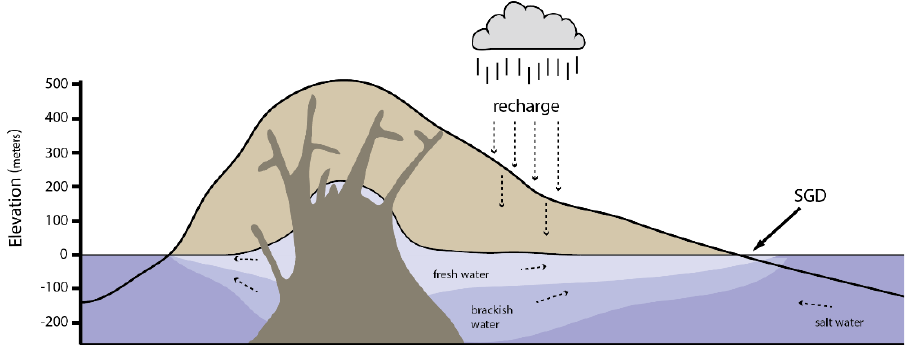
Figure 2. Rapa Nui hydrological model. Adapted with permission from ref [27]. Copyright © 2008, Springer-Verlag.